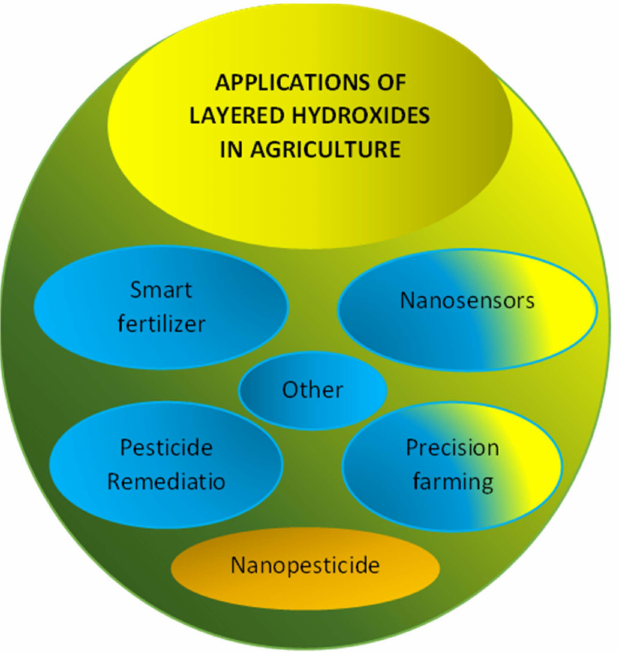
Figure 3. Various applications of layered hydroxides in